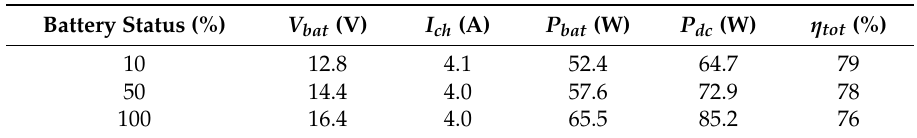
Figure 13. WPT charging system electronics on-board the drone. Table 3. Measured electrical performances of the WPT system for three charging statuses of the battery and T x = 100 mm T y = 40 mm.